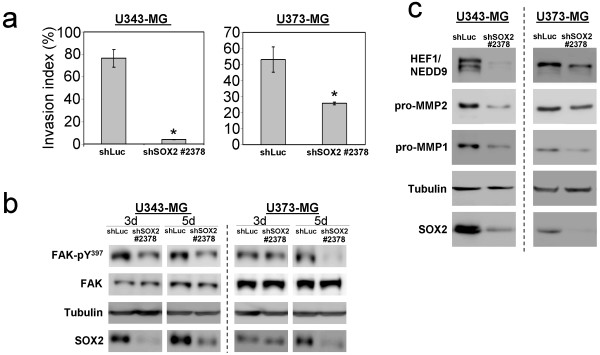
SOX2-RNAi affects adhesion, invasion and migration of glioma cells. a: Trans-well assay measuring the invasion of U343-MG- and U373-MG glioma cells with stable knockdown of SOX2 and of shLuc control cells using extra cellular matrix (ECM)-coated Boyden chambers. The calculation of the proteolysis-dependent invasion index was performed as described in the material and methods section. Bars indicate standard deviation. * p < 0.01 when cells with knockdown of SOX2 were compared to shLuc controls. b: Western blot analysis of focal adhesion kinase (FAK) and its activated phosphorylated form (FAK-pY397). FAK and FAK-pY397 was analyzed in SOX2 silenced (shSOX2-2378) and in control cells (shLuc) at two different time points 3 days (3 d) and 5 days (5 d) after transduction. Note the decrease in FAK-pY397 in cells with knockdown of SOX2. c: Western blot analysis showing diminished expression of the human enhancer of filamentation protein (HEF1/NEDD9), and of pro-matrix metalloproteinases (pro-MMPs) 1 and 2, in U343-MG and U373-MG glioma cells with knockdown of SOX2.